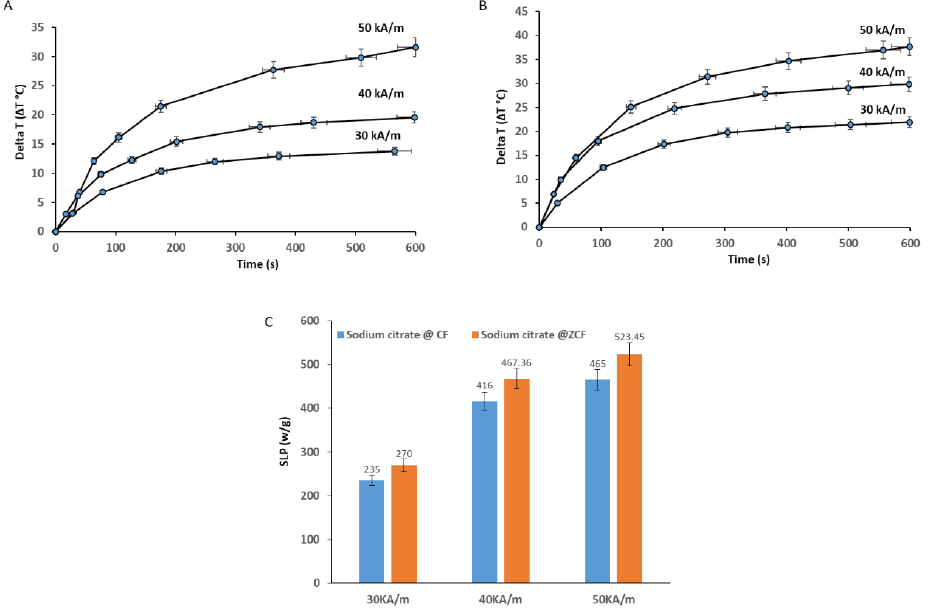
Figure 16. Heating profiles of sodium citrate@ CF-MNPs ( A ) and sodium citrate@ ZCF-MNPs ( B ) with magnetic field strengths (30, 40, and 50 kA/m) at a frequency of 97 kHz and SLP values ( C ). Table 2. Comparison between conventional co-precipitation methods and the current study. Sample Ref.